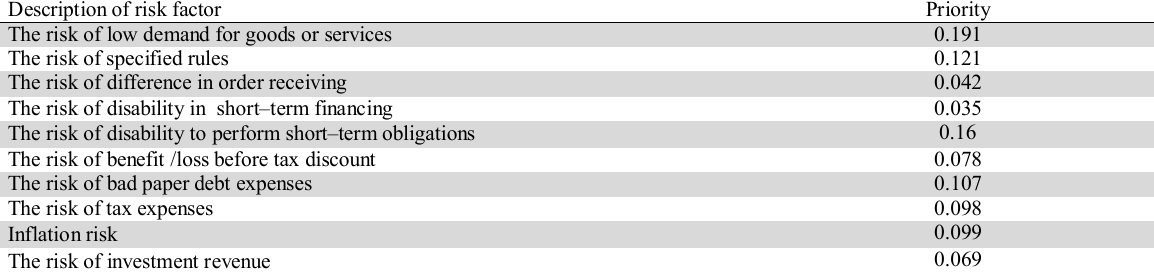
The summary of liquidity